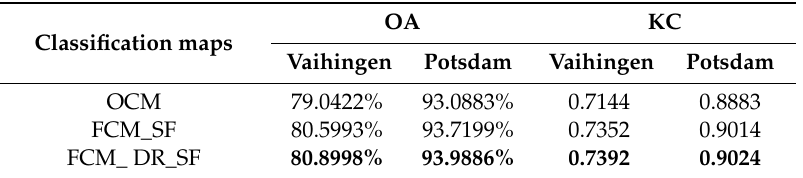
Table 3. Accuracy evaluation results: OCM represents the original classification map. FCM_SF and FCM_ DR_SF correspond to the final classification maps (FCMs) obtained by using SF and DR_SF. OA, overall accuracy; KC, Kappa coe ffi